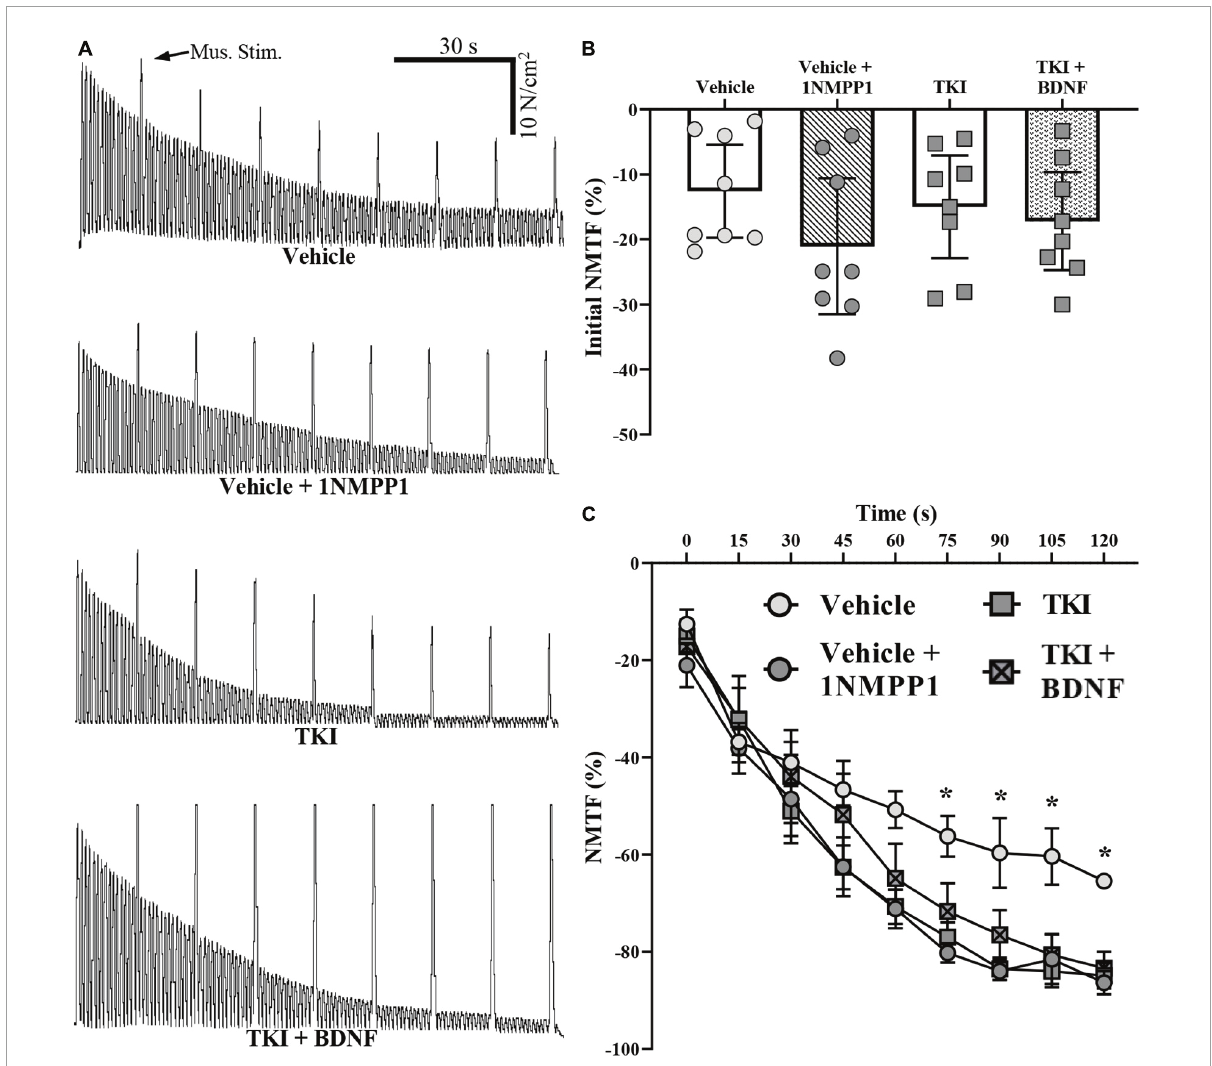
FIGURE3 Neuromuscular transmission failure (NMTF) occurs more rapidly in TrkB F 616 rat DIAm treated acutely (in bath) or chronically (14 days) with 1NMPP1. (A) Force traces of 120 s of NMTF inducing nerve stimulations, superimposed with direct muscle stimulation every 15 s of DIAm from control (vehicle), control following 45 min of pre-incubation with 1NMPP1 (vehicle + 1NMPP1, 14-day 1NMPP1-treated rats (TKI) and 14-day 1NMPP1-treated rats following 45 min of pre-incubation with BDNF (TKI + BDNF) rats. (B) Plot (mean ± 95% CI) illustrating unchanged initial DIAm NMTF in all groups (one-way ANOVA). (C) Plot (mean ± SEM) of time course of NMTF illustrating increased failure of vehicle + 1NMPP1, TKI and TKI + BDNF compared to vehicle rats (denoted by *). * P <